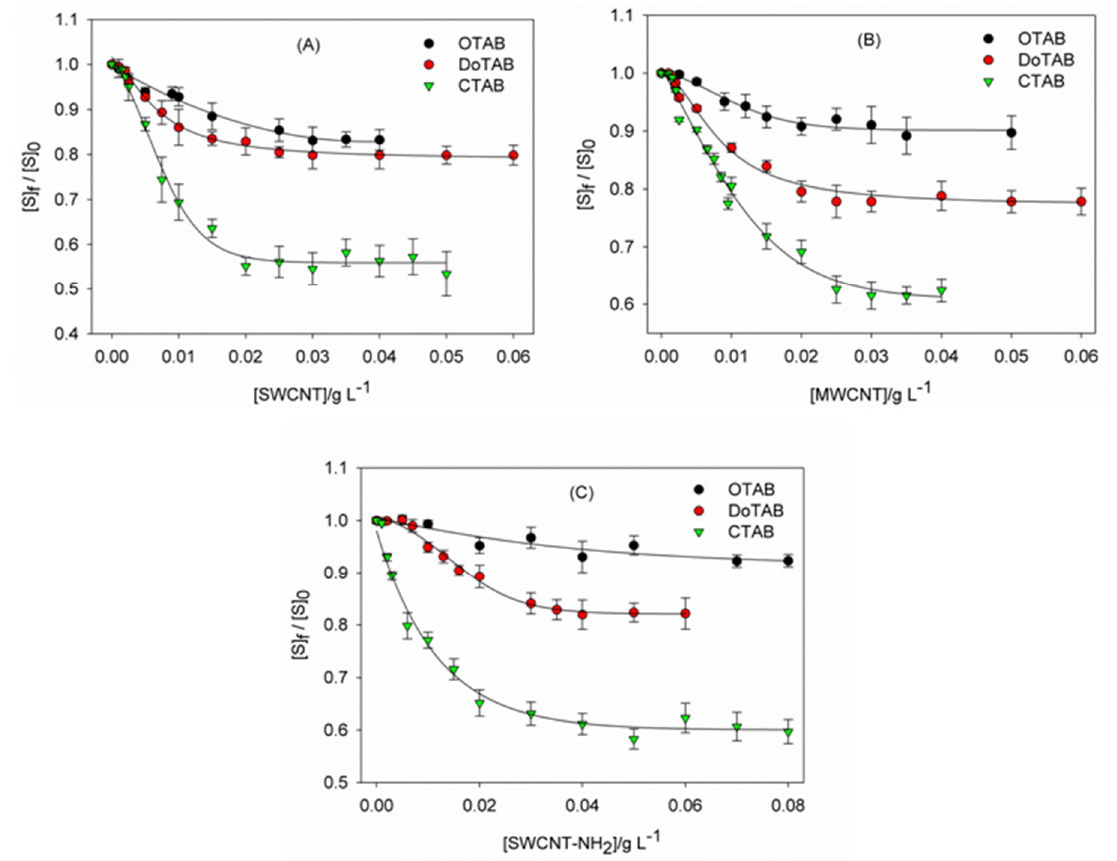
Figure 3. Plots of the relative free surfactant concentration versus the carbon nanotubes concentration in buffered aqueous solutions: ( A ) SWCNT (pH = 9); ( B ) MWCNT (pH = 9); and ( C ) SWCNT-NH 2 (pH = 3).